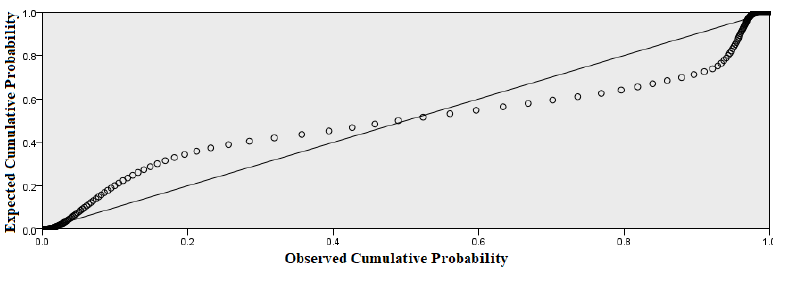
Figure 10. Residual analysis of MLR.